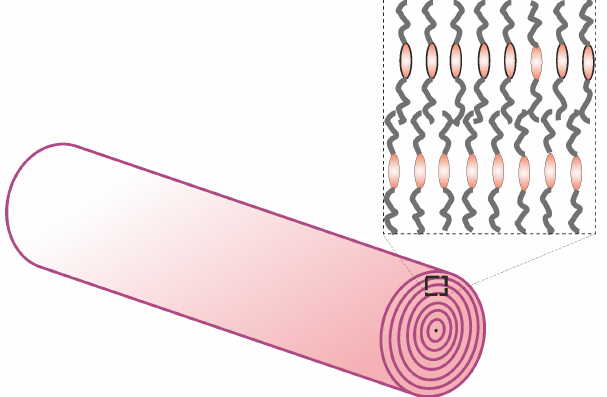
Figure 1. A smectic microfilament with the proposed stabilizing layer arrangement [26,29] for filament diameters that are between several nanometers and a few dozen micrometers. In our macroscopic columns, the layer structure was disordered and this stability mechanism was not